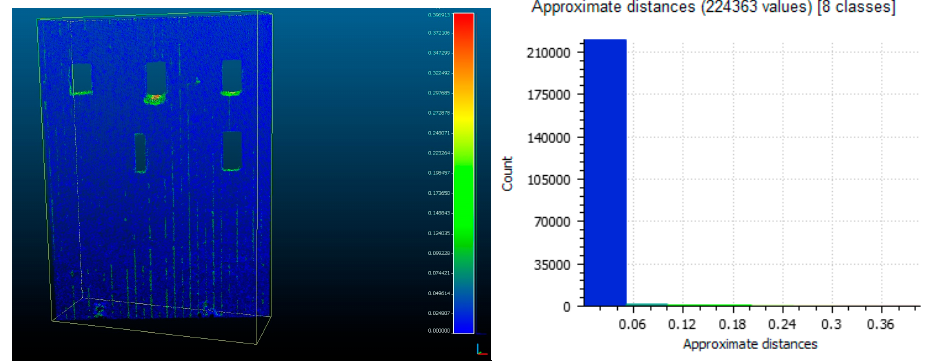
Figure 28. Discrepancy map and histogram between the TLS cloud and UAV Nadir + Oblique in Pix4D.